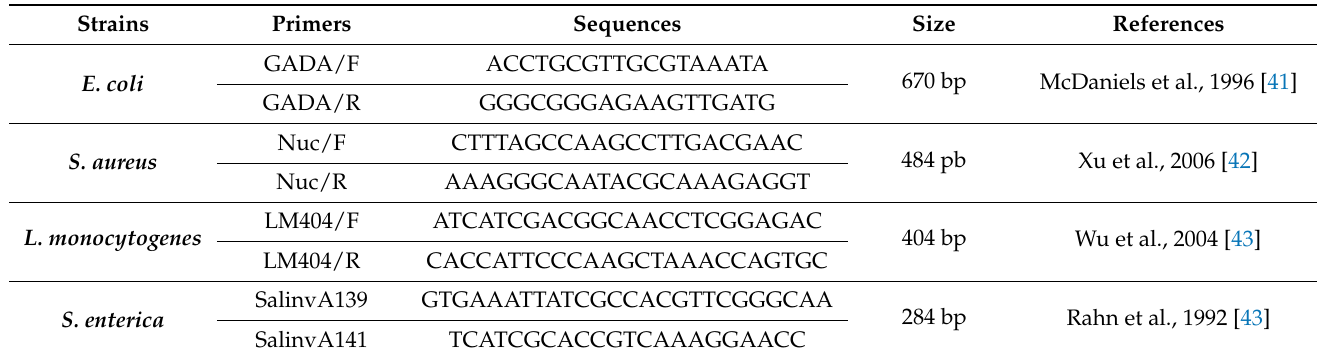
Table 1. Primers